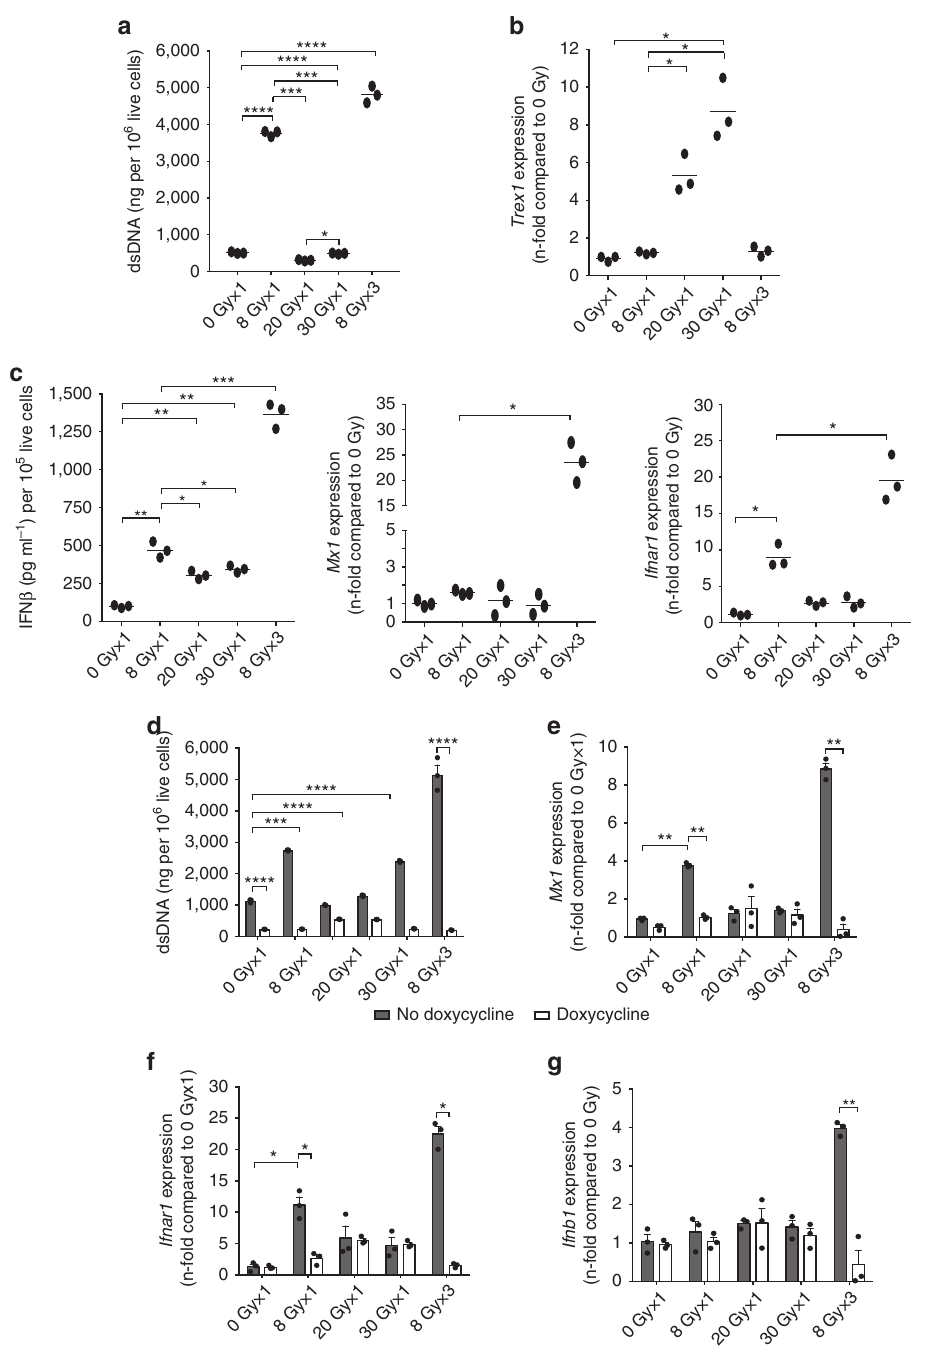
Figure 3 | Trex1 is induced by high dose radiation and degrades IFN-inducing cytoplasmic DNA. ( a – c ) Cytoplasmic dsDNA accumulation ( a ), Trex1 gene expression ( b ), IFN b secretion and Mx1 and Ifnar1 gene expression ( c ) in TSA cells treated with various radiation doses ( n ¼ 3). ( d – g ) TSA KI Trex1 cells were cultured without (grey bars) or with doxycycline (white bars) to induce Trex1 expression (Supplementary Fig. 3b) before measuring cytoplasmic dsDNA accumulation ( d ), Mx1 ( e ), Ifnar1 ( f ) and Ifnb1 ( g ) gene expression induced by radiation ( n ¼ 3). (Duplicate; * P o 0.05; ** P o 0.005; *** P o 0.0005; **** P o 0.0001: t -test). All data are mean ± s.e.m. gene expression can be upregulated by IFN-stimulatory DNA 17 . IFN b and expression of ISGs Mx1 , Ifnar1 and Cxcl10 were To determine if Trex1 could control the abundance of markedly increased only by the 8GyX3 regimen of radiation cytoplasmic DNA in TSA cells treated with different radiation (Fig. 3c and Supplementary Fig. 3a). Interestingly, while a single doses, its expression was analysed. A significant increase of Trex1 dose of 8 Gy induced expression of IFNAR1 and modest levels of was detected in cells treated with a single dose of 20 and 30 Gy IFN b , repeated irradiation of TSA cells with 8 Gy amplified ISGs induction and IFN b secretion, explaining the absence of abscopal but not 8 Gy, even when given in three consecutive fractions, for a total dose of 24 Gy over 3 days (Fig. 3b). In contrast, release of responses seen with a single dose of 8 Gy þ anti-CTLA4 (Fig. 1b). NATURE COMMUNICATIONS|8:15618|DOI: